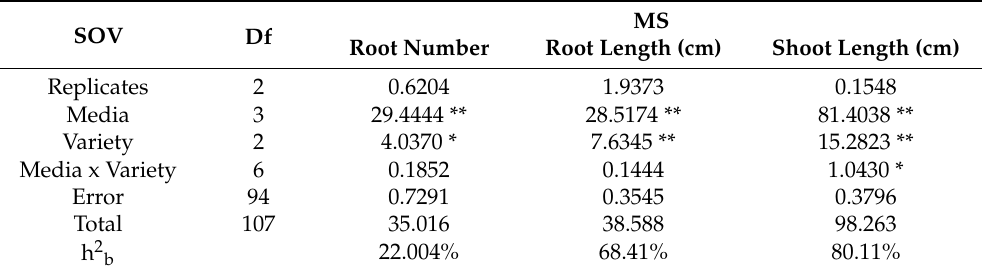
Figure 6. Responses of Amri, Magdoul and Barhy varieties in the multiplication stage. ( A ). Number of somatic embryos of the three multiplication media (PM1, PM2 and PM3). ( B ). Number of somatic embryos of the three varieties (Amri, Magdoul and Barhy). ( C ). The number of shoots of the three multiplication media (PM1, PM2 and PM3). ( D ). The number of shoots of the three varieties (Amri, Magdoul and Barhy). Note: Charts with the same letter are not statistically different at p < 0.05. Different letters denote a significant difference among culture media at p < 0.05. Table 2. Mean sum of squares (MS) of the number of somatic embryos and the shoot number in Amri, Barhy and Magdoul varieties. Table 3. Mean sum of squares (MS) of roots number, root length and shoot length in Amri, Barhy and Magdoul